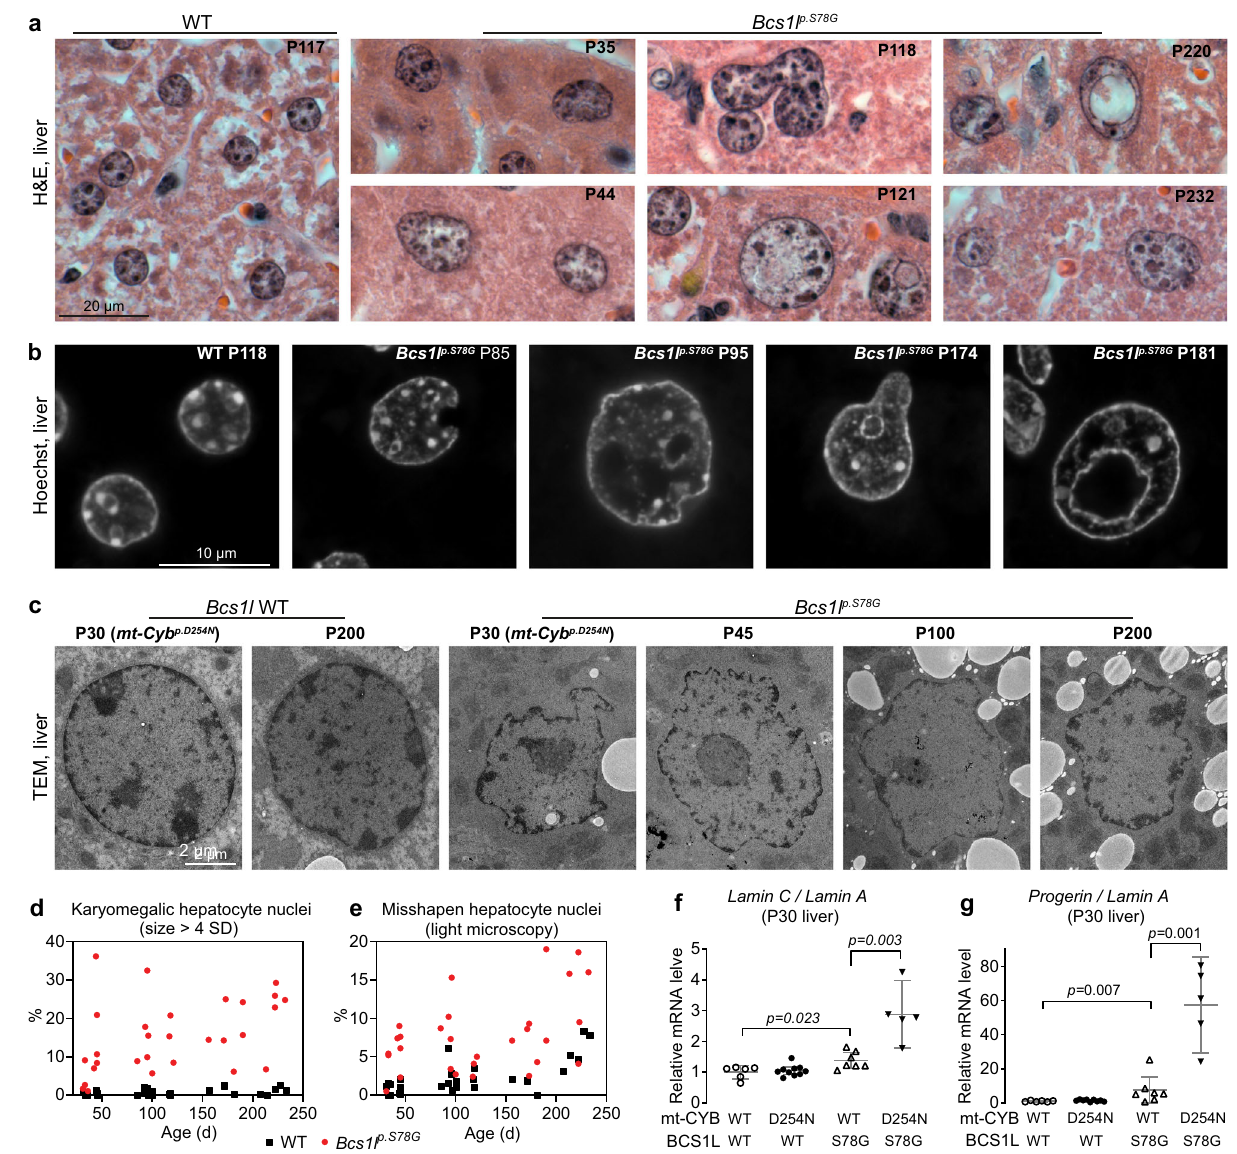
Fig. 3 | Morphological aberrations of CIII-de fi cient hepatocyte nuclei. a H&E- stained liver sections showing typical WT hepatocyte nuclei and the spectrum of aberrant Bcs1l p.S78G hepatocyte nuclei (anisokaryosis, karyomegaly, uneven nuclear envelope, atypical shapes, nuclear envelope blebs and invaginations, intranuclear cytoplasmic inclusion-like structures). b High-magni fi cation images of Hoechst- stained hepatocyte nuclei. c Representative electron micrographs of hepatocyte nuclei. Two samples from the mt-Cyb p.D254N background are indicated in par- entheses. Supplementary Fig. 2d shows the corresponding whole-cell cross